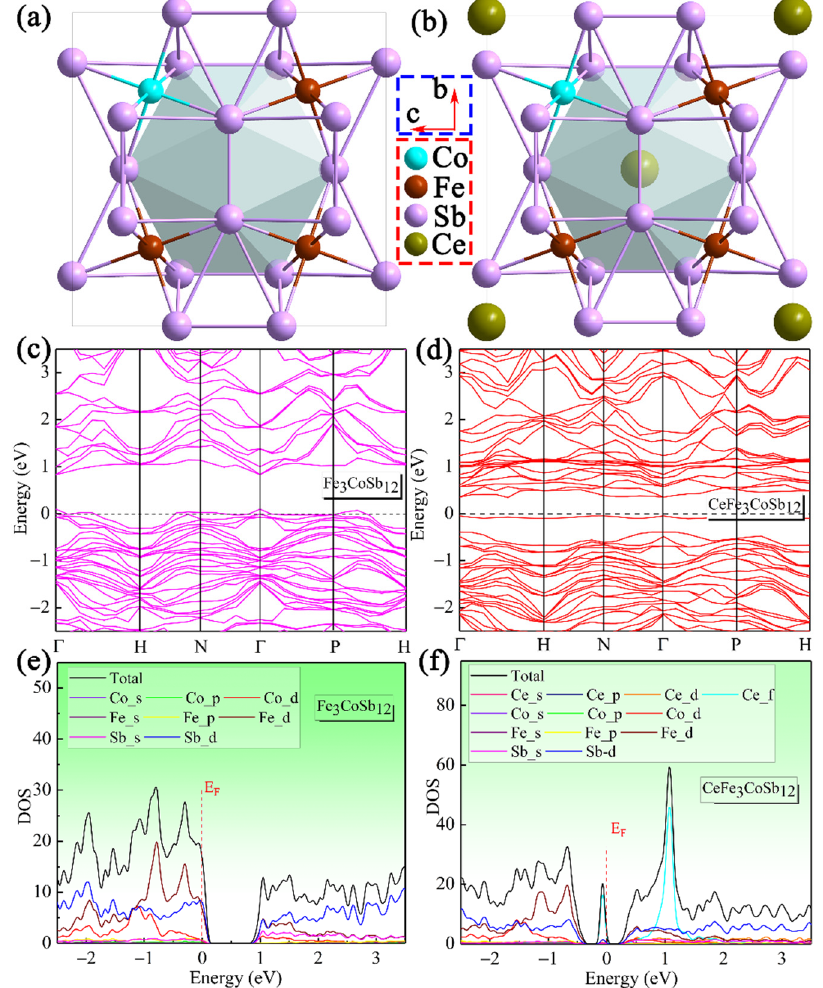
Figure 1. Band structures and density of states (DOS) of the unfilled and Ce-filled Fe 3 CoSb 12 -based skutterudites: The conventional unit cell of unfilled ( a ) and Ce-filled ( b ) Fe 3 CoSb 12 -based skutteru- dites. Calculated band structures of unfilled ( c ) and Ce-filled ( d ) Fe 3 CoSb 12 -based skutterudites and Calculated DOS of unfilled ( e ) and Ce-filled ( f ) Fe 3 CoSb 12 -based